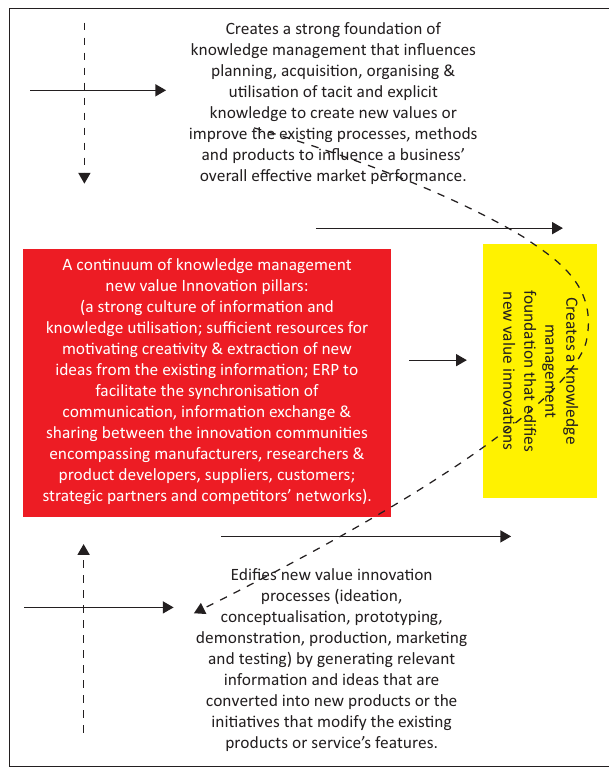
FIGURE 1: A continuum of knowledge management–new value innovation pillars that create an effective knowledge management foundation that edifies the effectiveness of the process of new value